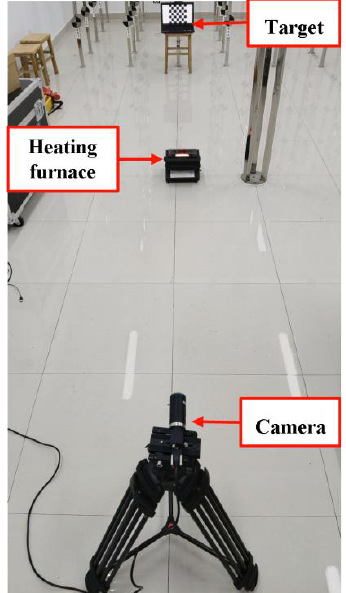
Figure 2. Static target displacement measurement experimental setup.